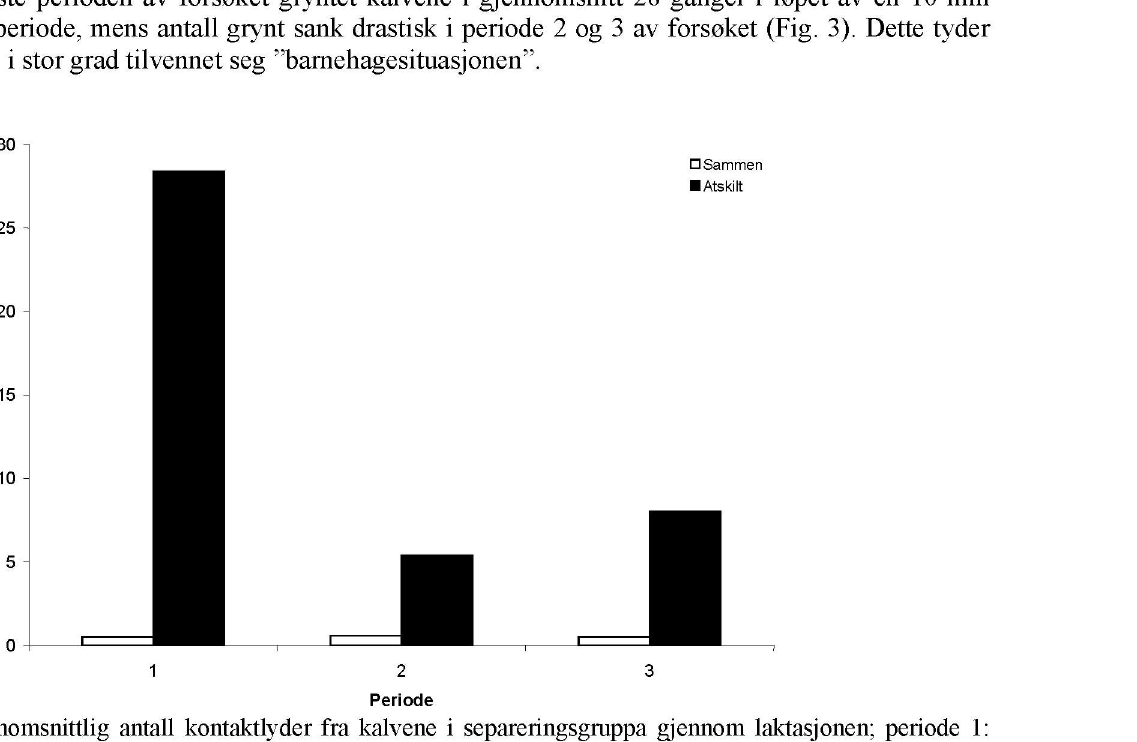
Fig. 3. Gjennomsnittlig antall kontaktlyder fra kalvene i separeringsgruppa gjennom laktasjonen; periode 1: tidlig i juli; 2: sent i juli og 3: sent i august. Verdiene gjelder for en 10. minutters observasjonsperiode. Åpne søyler: sammen med simla; svarte søyler: atskilt fra